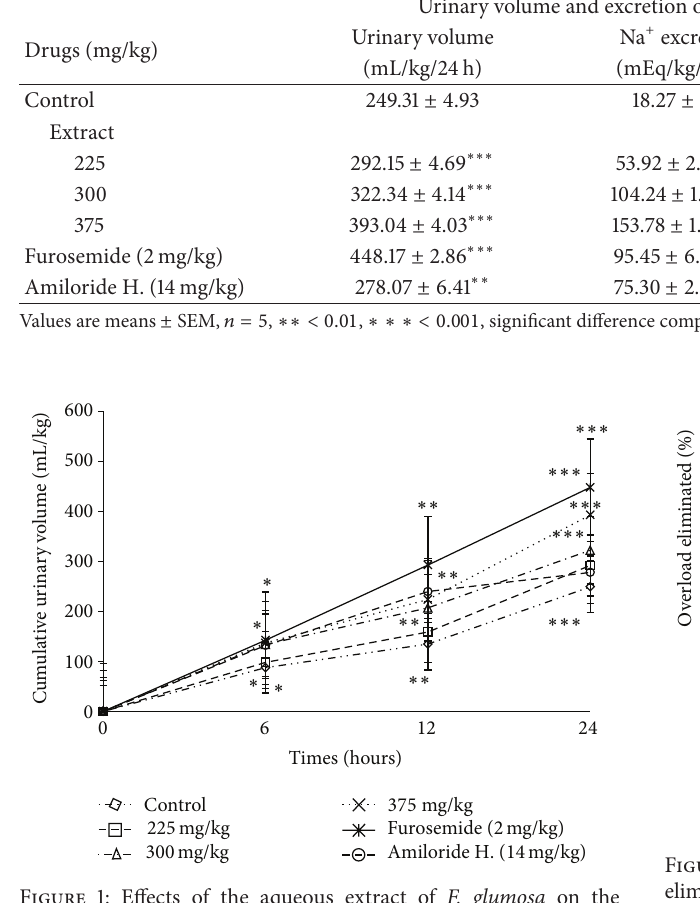
Figure 1: Effects of the aqueous extract of F. glumosa on the cumulative urinary volume excretion. Values are means ± SEM, 𝑛 = 5 , ∗ < 0.05 , ∗∗ < 0.01 , and ∗ ∗ ∗ < 0.001 , significant difference compared to the control.